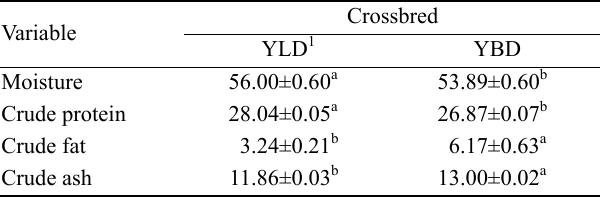
two different three-way crossbreed